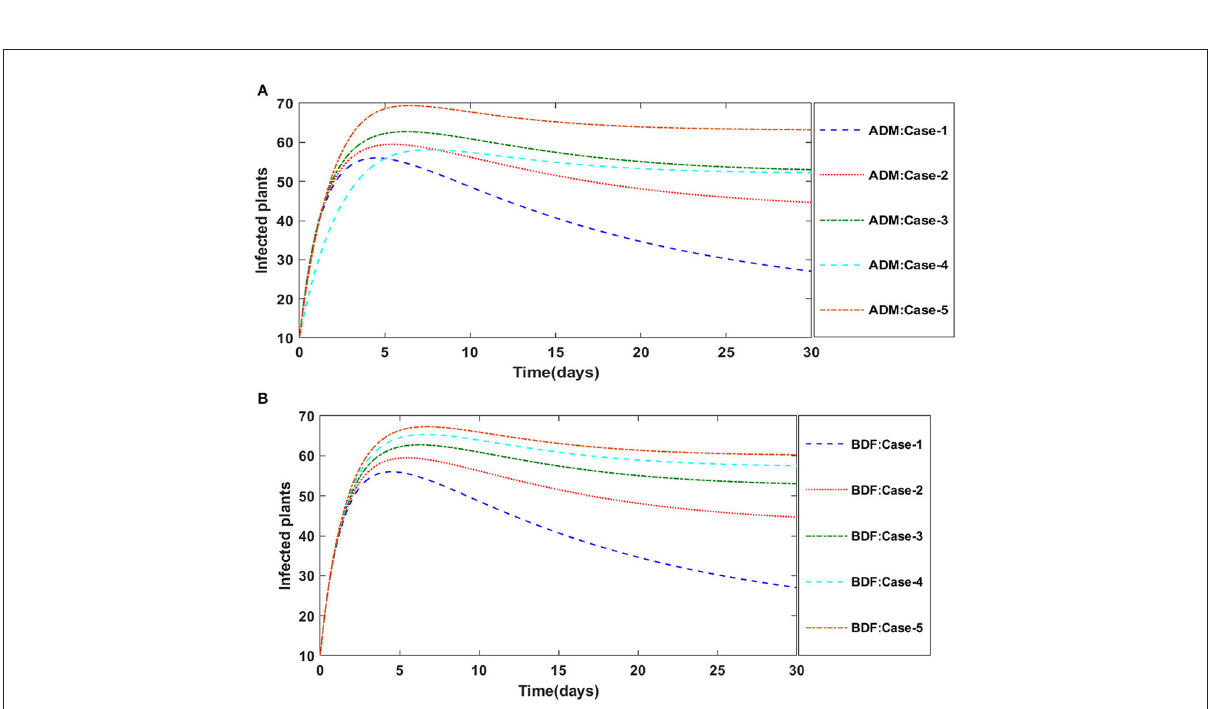
FIGURE3 (A) Dynamics of infected plants for the varition in γ 1 using ADM for model A. (B) Dynamics of infected plants for the varition in γ 1 using BDF for model